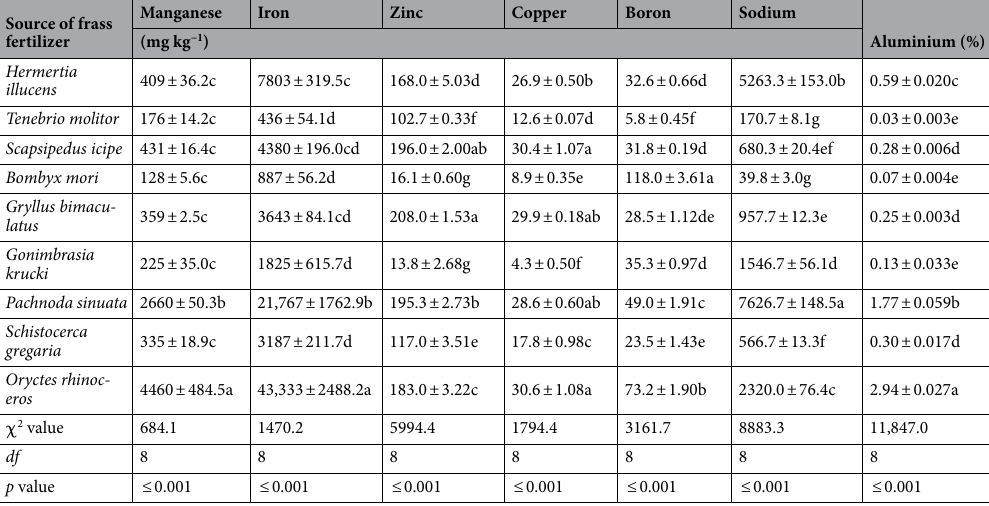
Table 2. Concentrations of micronutrients in frass fertilizers produced by different insect species. In the same column, means (± standard error) followed by the same letters are not significantly different at p ≤ 0.05, n = 3.